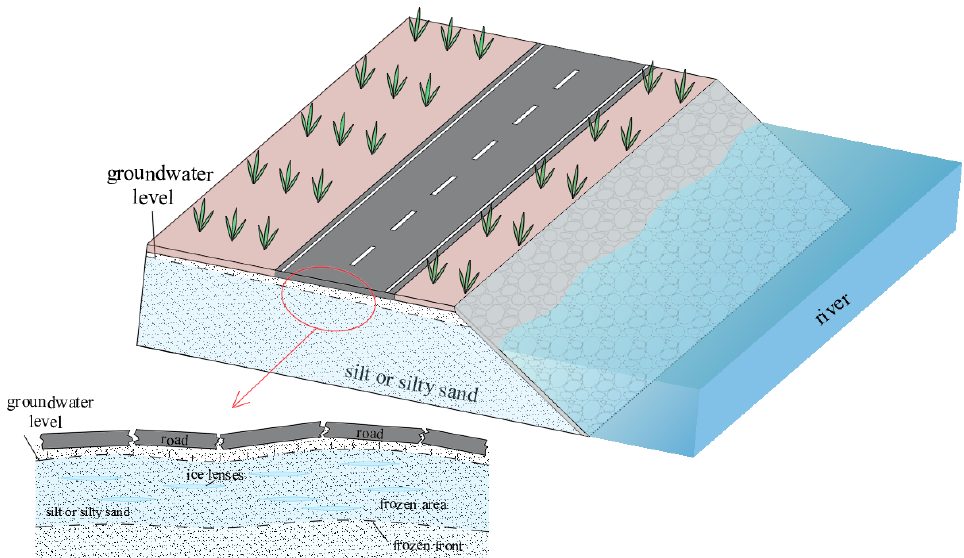
Figure 1. Pavement damage during freeze–thaw cycles in saturated cohesionless soil.